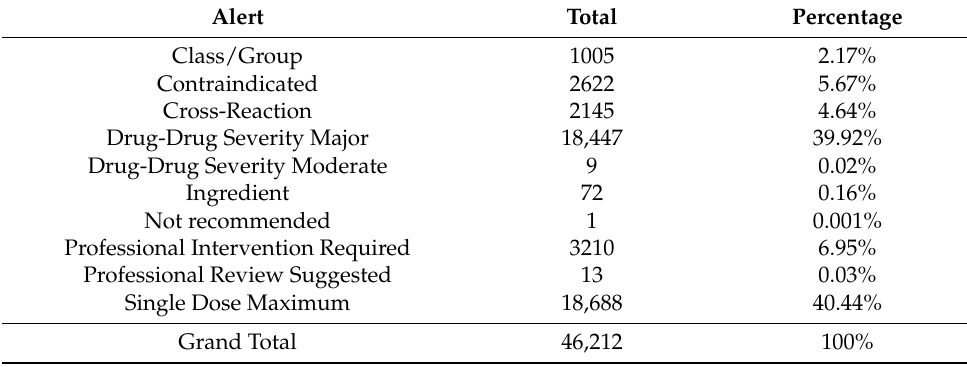
Table 7. Total of alerts by type.